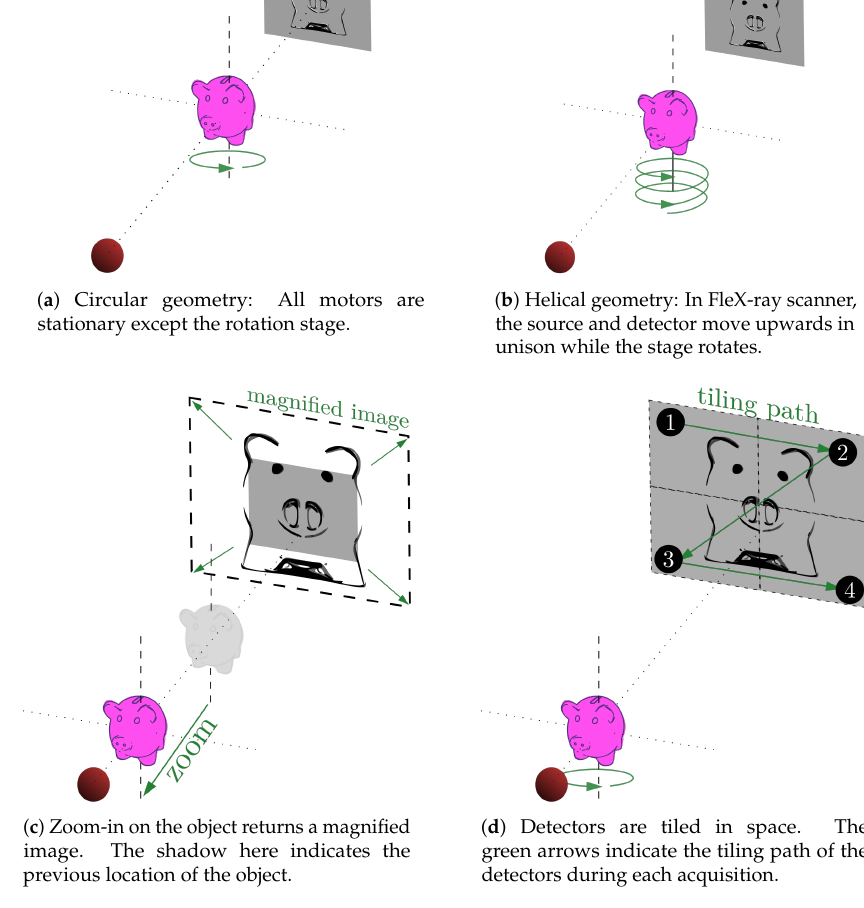
Figure 3. The top row illustrates typical scan geometries and the bottom row the process of spatial tiling of the detector in FleX-ray